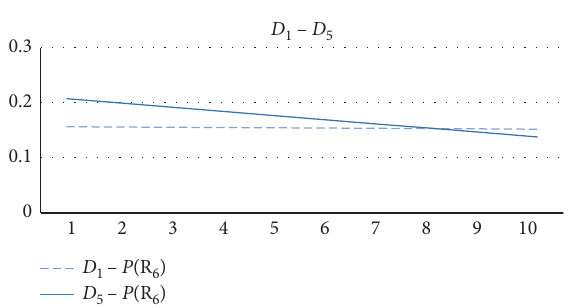
Figure 5: Sensitivity analysis of D